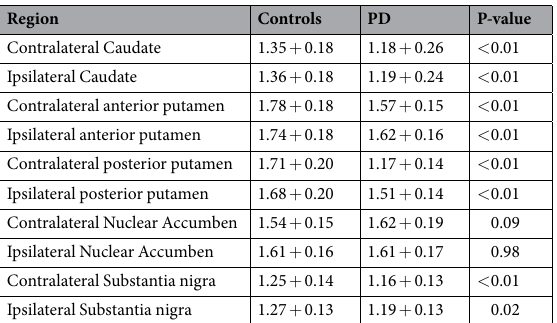
Table 2. Regional intensity differences between controls and patients with PD in the early phase 18 F-( + )DTBZ images.